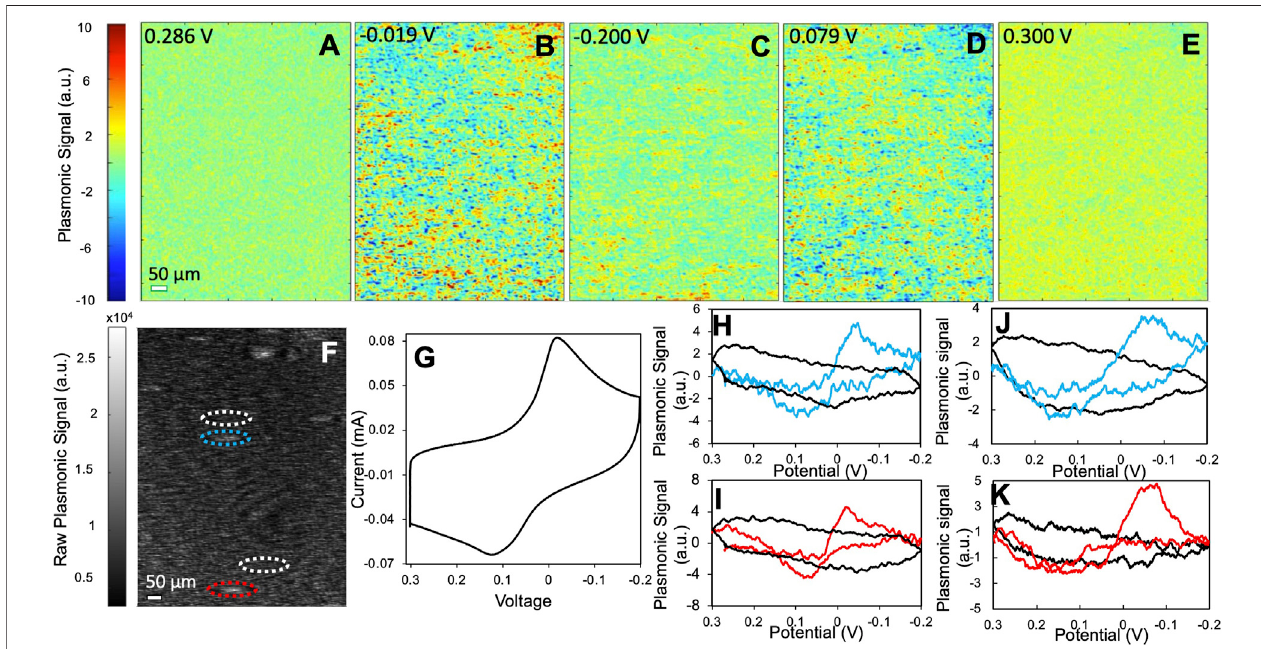
FIGURE4| TheelectrochemicalactivityoftypeIIPBNPs. (A – E) RepresentativePEMimagesoftypeIIPBNPsatdifferentpotentials. (F) RawSPRMimageoftypeII PBNPs. (G) PotentiostatCVoftheentireelectrodeand (H , I) plasmonicCVsfromtwoPBNPs(blueandred)andtheirneighboringbackgroundareas(black)aslabeledin (F) , and (J , K) plasmonic CVs from two type II PBNPs (blue and red) synthesized from 10 g PVP protocol and their neighboring background areas (black). Scan rate: 0.05 V/s. Solution: 1.0 M KNO 3 .